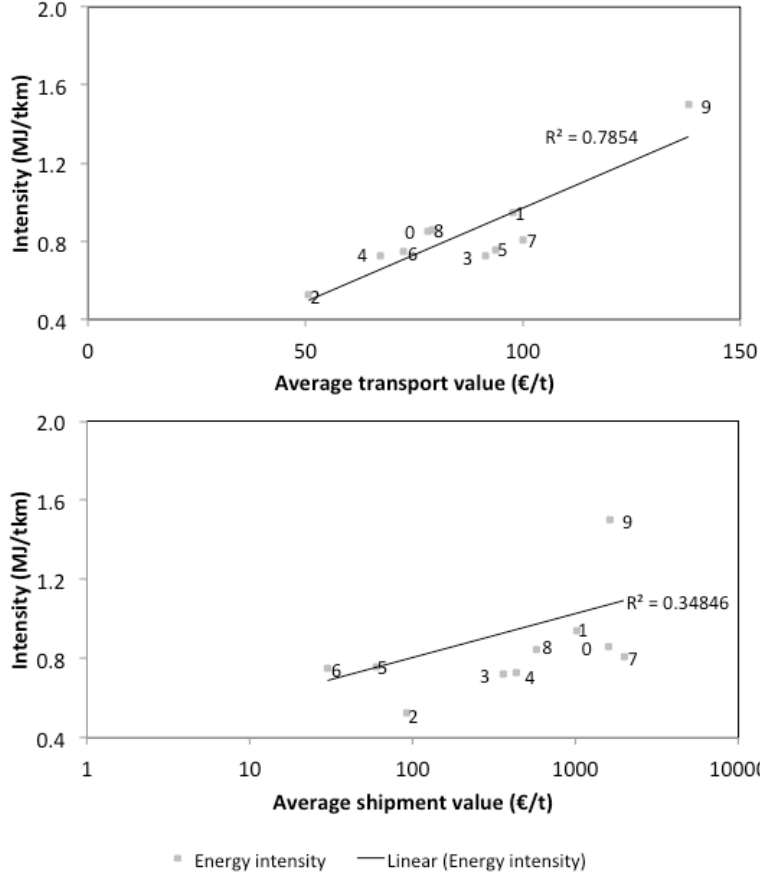
Figure 7. Energy intensity of road transport operations in Spain, average operation transport cost (€/t, upper graph), and average value of the shipment on a logarithmic scale (€/t, lower graph), 2006. The linear fits reported the square correlation coefficients. Source: MFO, 2009; and this